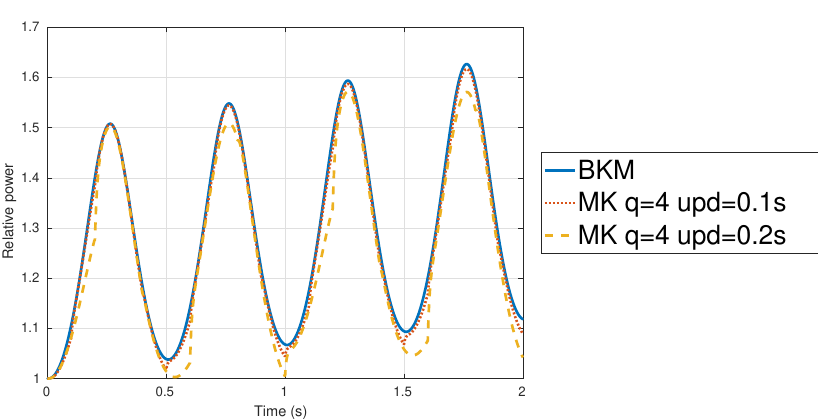
Figure 2: Relative power for the Langenbuch transient. Table 1: Performance of the Updated modal method with fixed